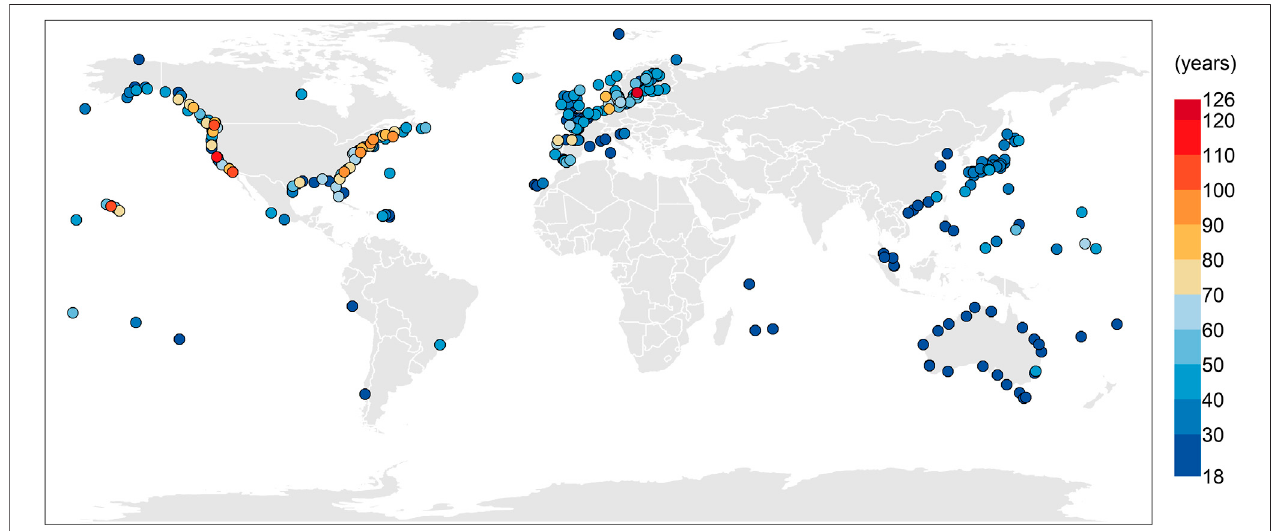
FIGURE 1 | Locations of tide gauges and the number of overlapping years. Only tide gauges with ≥ 18 overlapping years were used in this